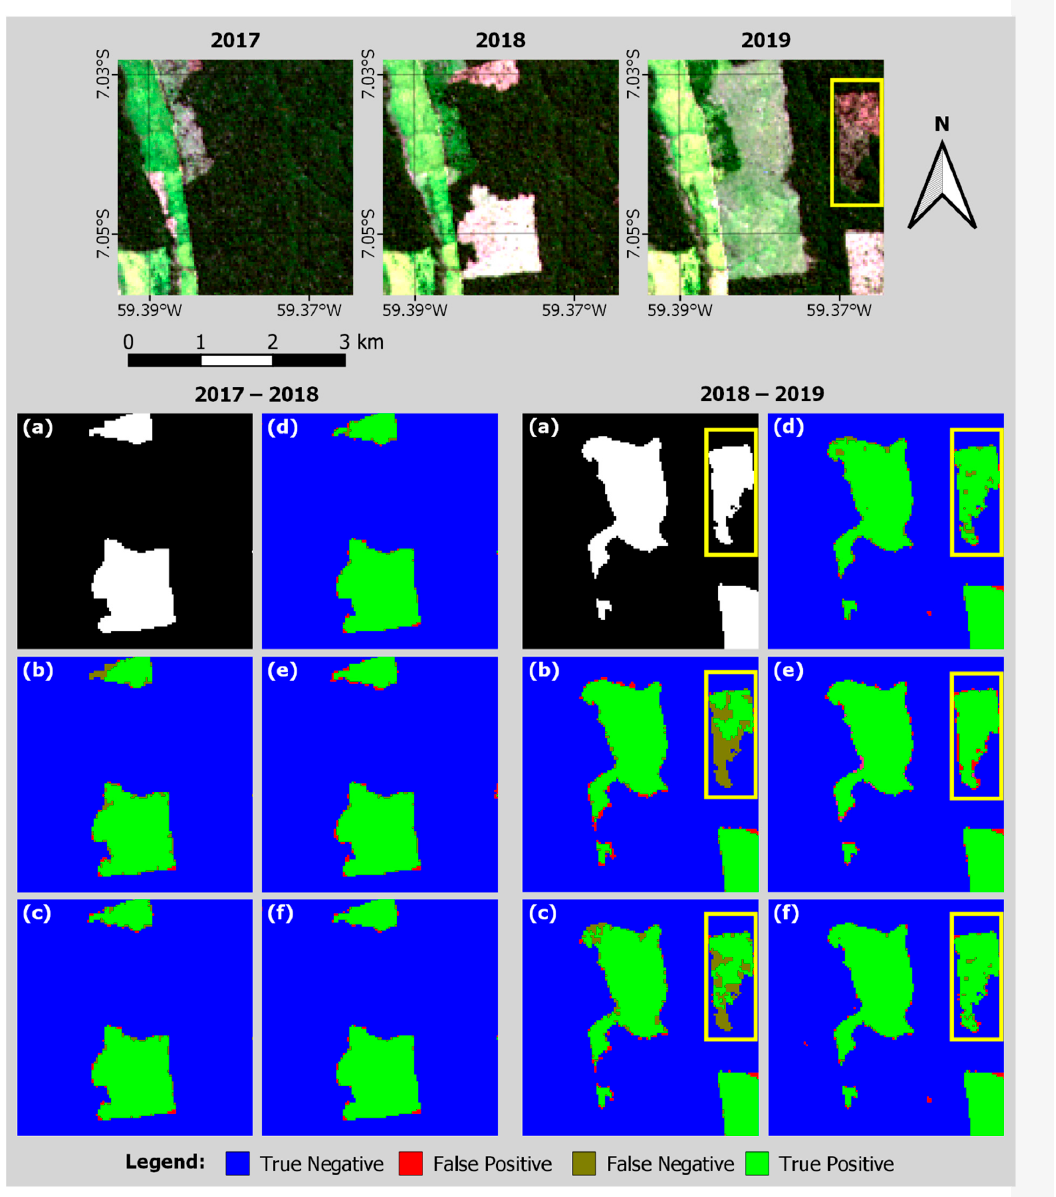
Figure 10. Second example location within the test site with the ( a ) ground truth and classifications made by the ( b ) RF, ( c ) MLP, ( d ) SharpMask, ( e ) U-Net, and ( f ) ResUnet models in each time sequence. The yellow rectangle highlights an example of a “hard-to-classify” deforestation patch.